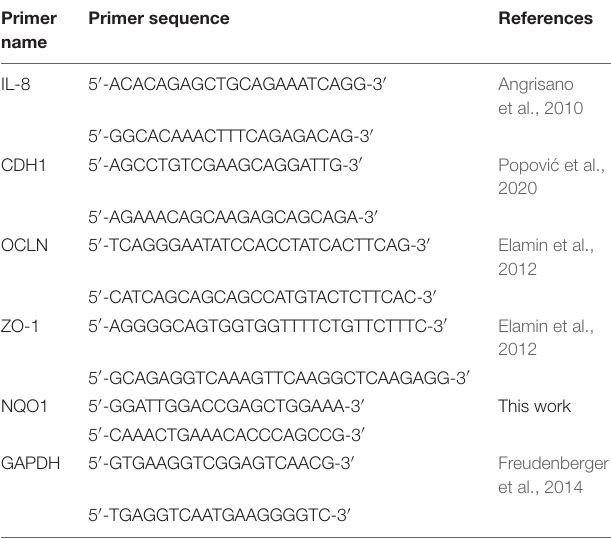
TABLE 2 | List of primers used for real-time PCR analysis in this